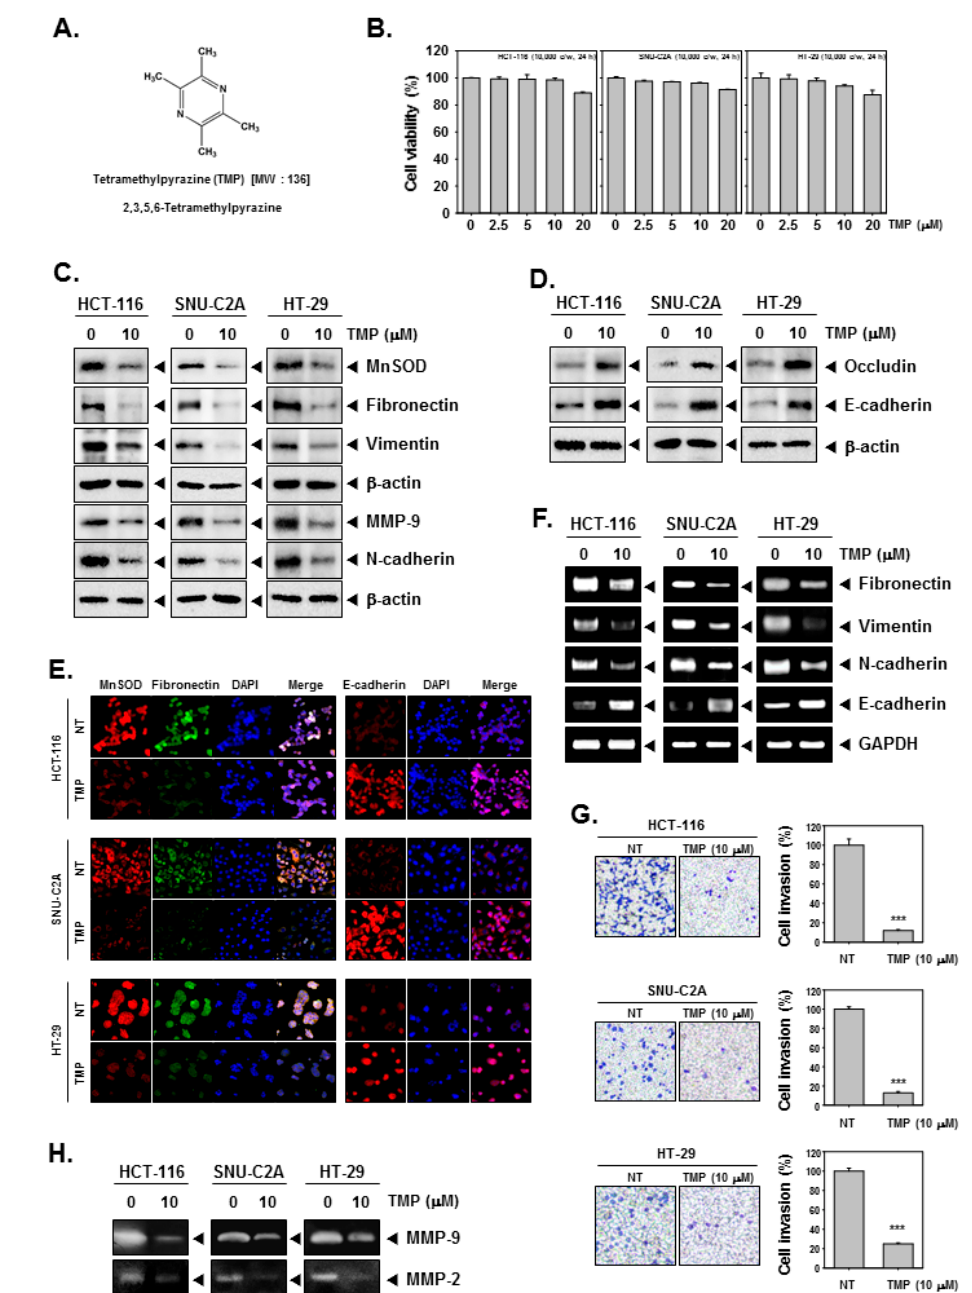
Figure 1. Effects of TMP on EMT in HCT-116, SNU-C2A, and HT-29 cells. ( A ) The chemical structure of TMP. ( B ) HCT-116, SNU-C2A, and HT-29 cells (1 × 10 4 cells/well) were treated with different doses of TMP for 24 h, and cell viability was quantified. ( C , D ) HCT-116, SNU-C2A, and HT-29 cells were exposed to TMP (10 µ M) for 24 h. Whole-cell lysates were used to evaluate the expression of indicated proteins by Western blot analysis. ( E ) HCT-116, SNU-C2A, and HT-29 cells were incubated with 10 µ M of TMP for 24 h. The expression of indicated proteins was analyzed using immunocytochemistry. ( F ) HCT-116, SNU-C2A, and HT-29 cells were incubated with TMP (10 µ M) for 24 h. Total RNA was extracted from cells and transcribed into cDNA to evaluate the expression of indicated transcripts. GAPDH was used as a loading control. ( G ) HCT-116, SNU-C2A, and HT-29 cells were incubated with 10 µ M of TMP, and cell invasion was analyzed by Boyden chamber assay. ( H ) The activities of both MMP-2 and 9 were evaluated by zymography. All the experiments were repeated at least thrice. *** p < 0.001 vs. non-treated (NT) cells.